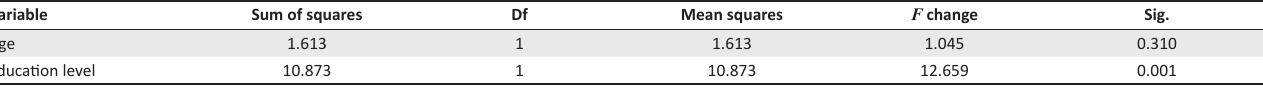
TABLE 4: ANOVA results.